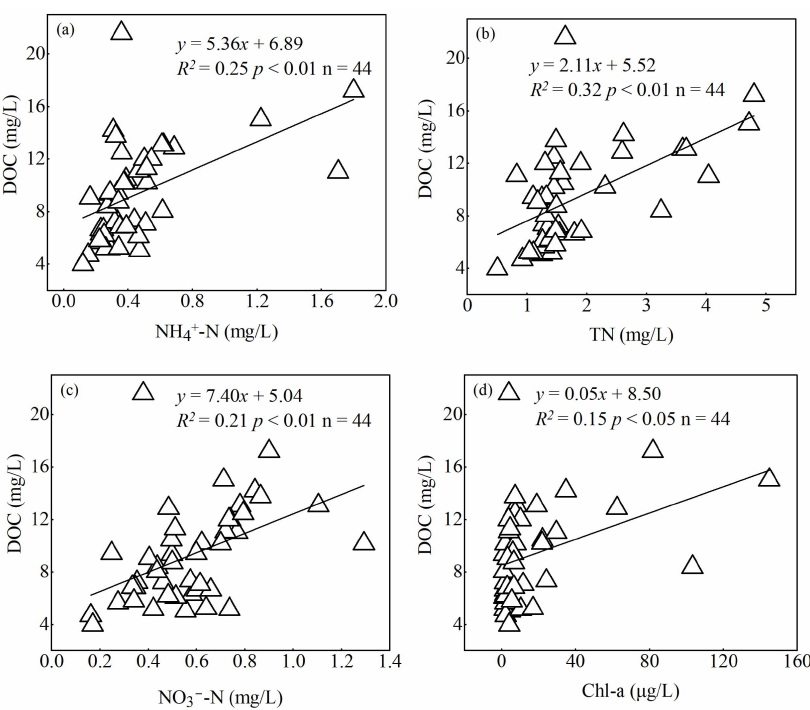
Figure 5. Correlations between DOC concentration and NH 4+ -N concentration ( a ), between DOC concentration and TN concentration ( b ), between DOC concentration and NO 3 − -N concentration ( c ), and between DOC concentration and Chl-a concentration ( d ) of ponds at watershed